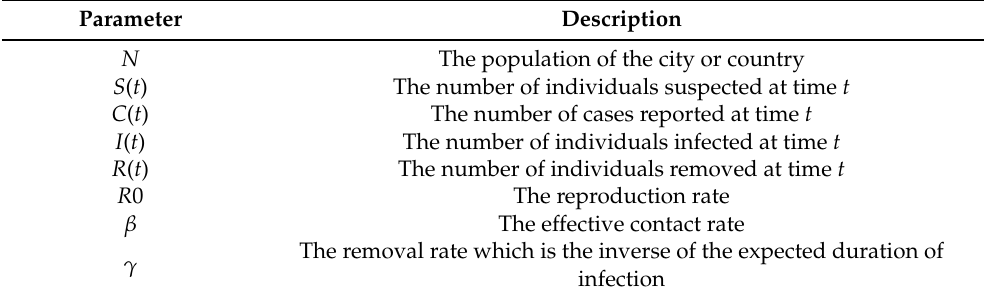
Table 1. Traditional SIR Model